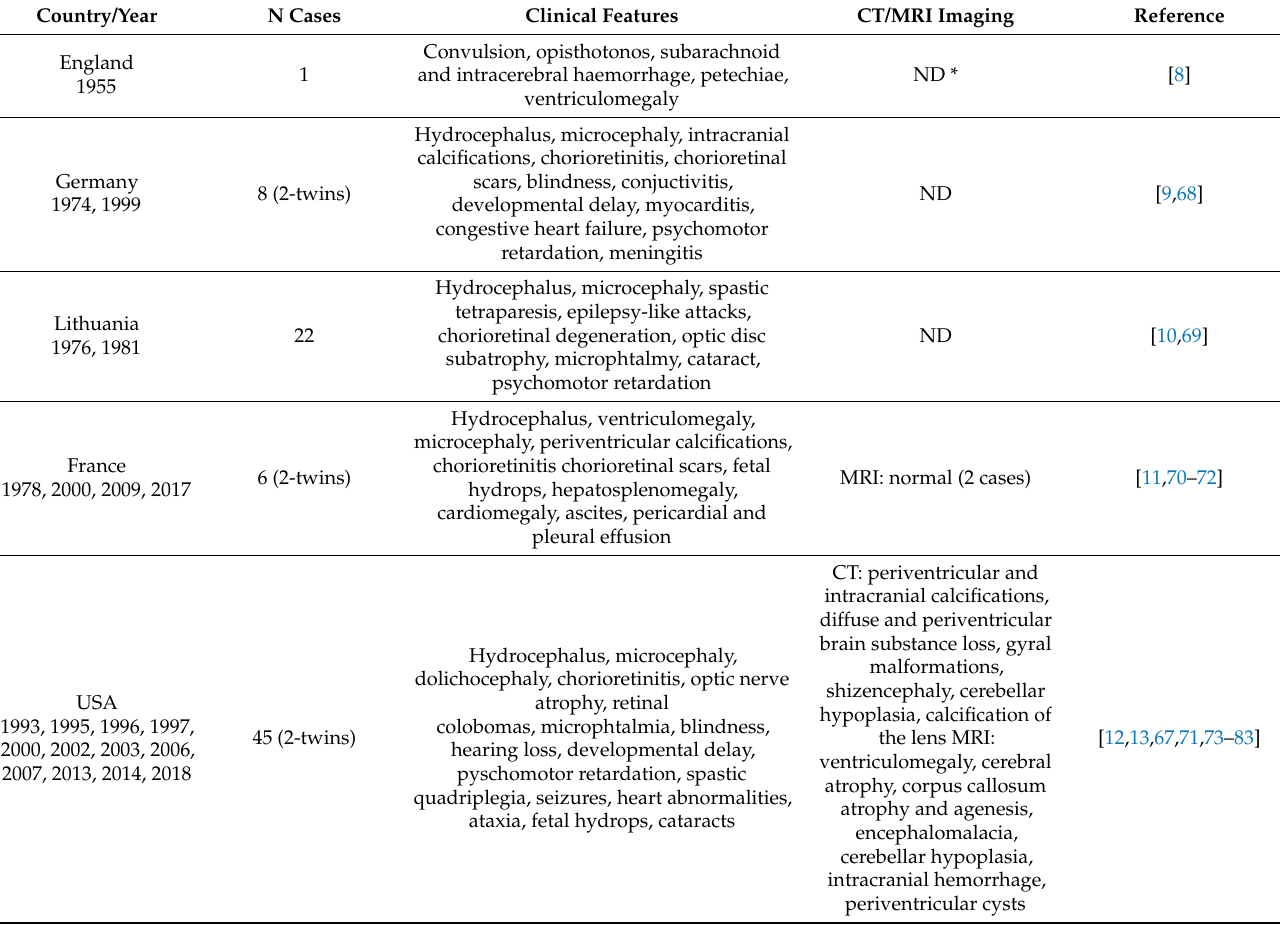
Table 2. Congenital LCMV